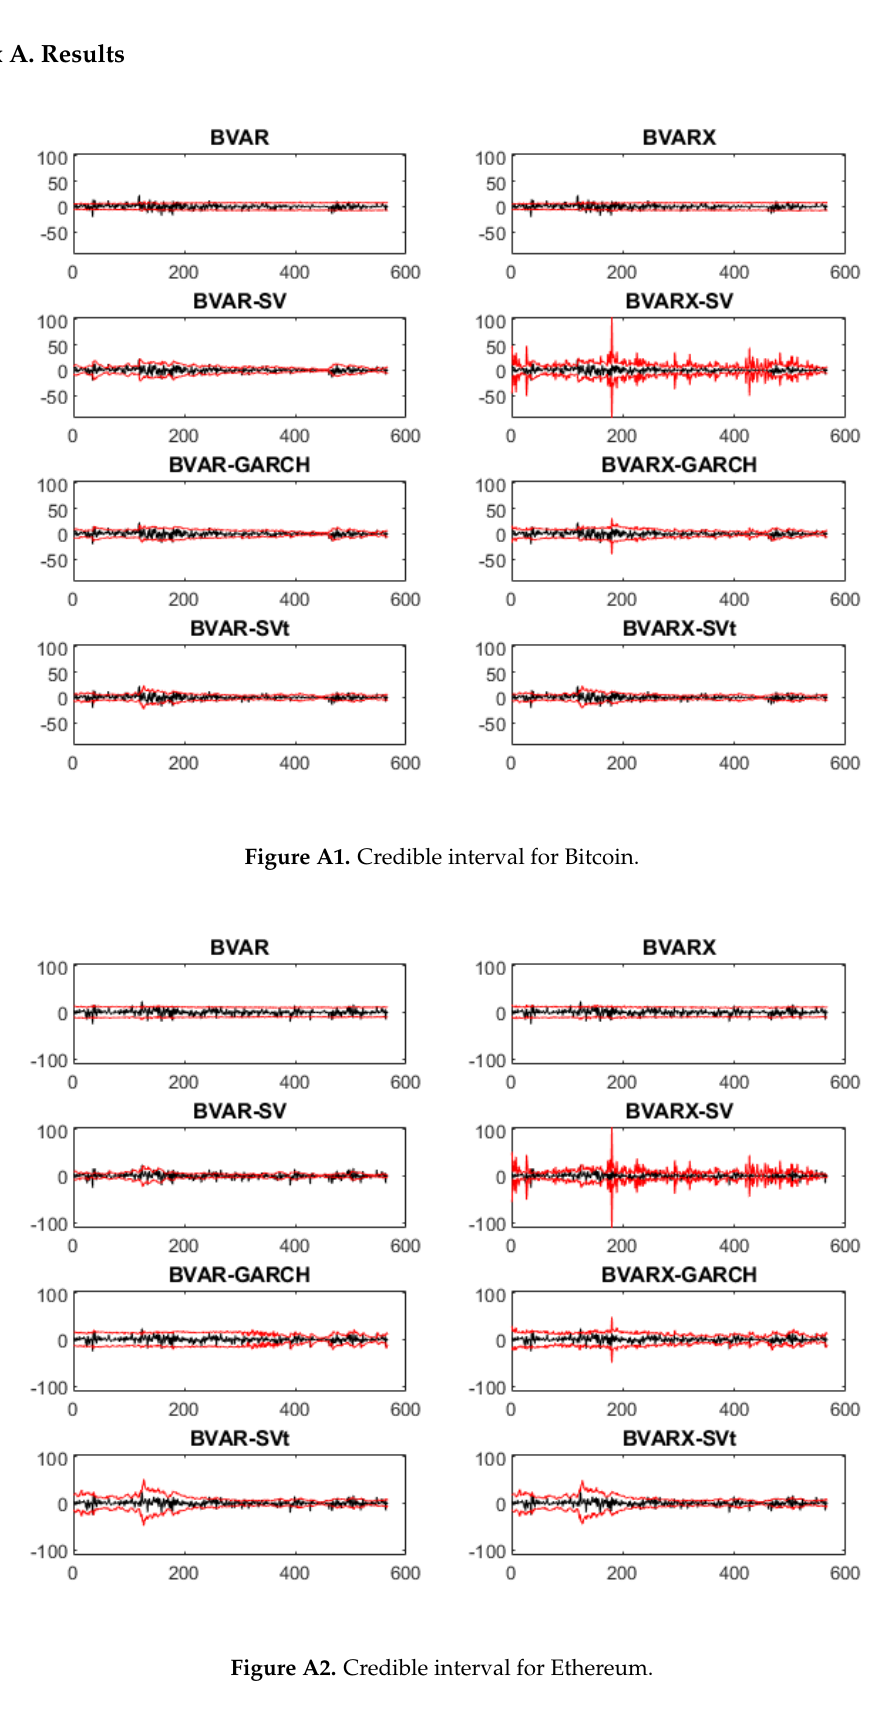
Figure A2. Credible interval for